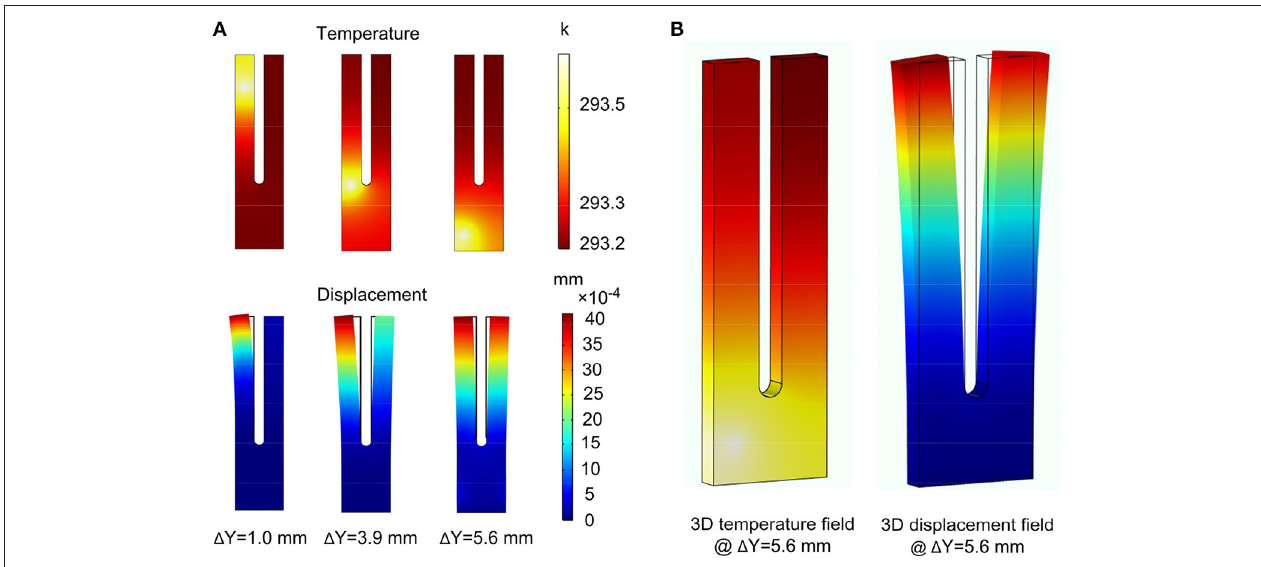
FIGURE 10 | Calculated temperature and displacement fields of the QTF in a QEPTS sensor. (A) Two-dimensional (2D) temperature and displacement fields at different 1 Y. (B) Three-dimensional (3D) temperature and displacement fields at 1 Y of 5.6mm. Reprinted with permission from [95] © The Optical Society.